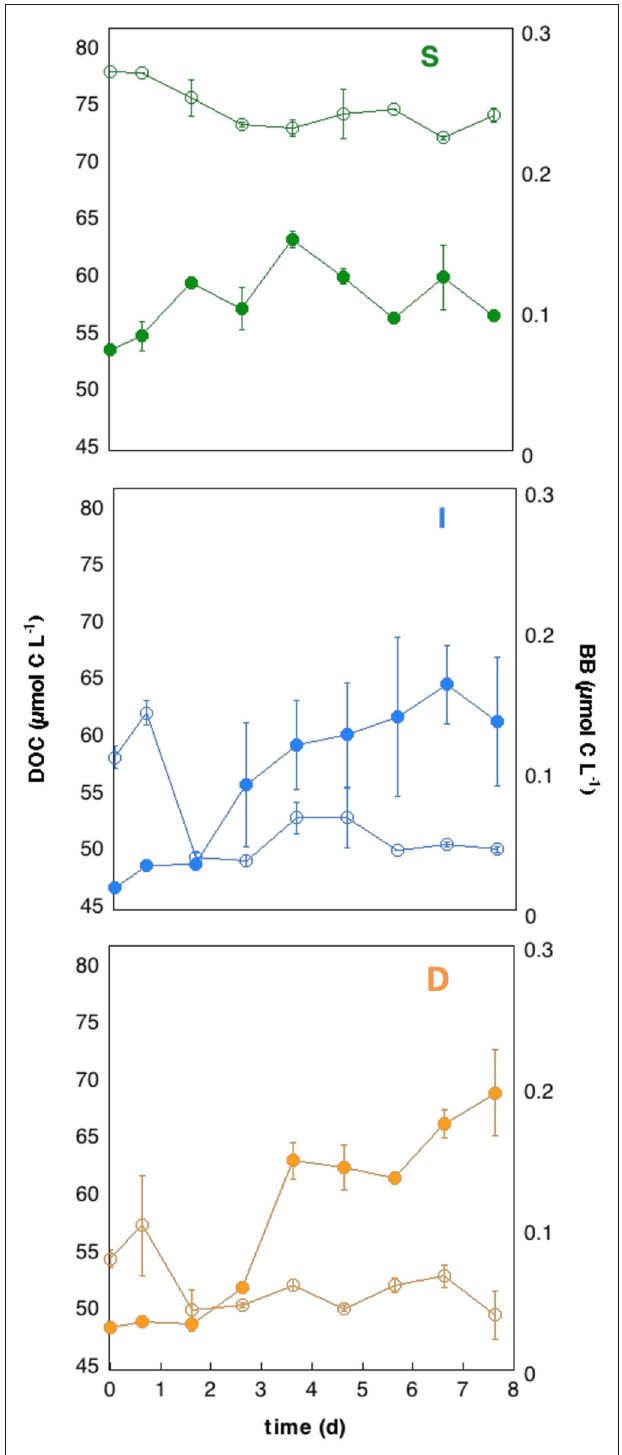
FIGURE 2 | Carbon dynamics within the incubations. Evolution of averaged ± SD of bacterial biomass (BB, µ mol C L − 1 ) and dissolved organic carbon (DOC, µ mol C L − 1 ) concentrations along the incubations, from the different water layers studied: surface (S, green), intermediate (I, blue) and deep scattering layer (D,